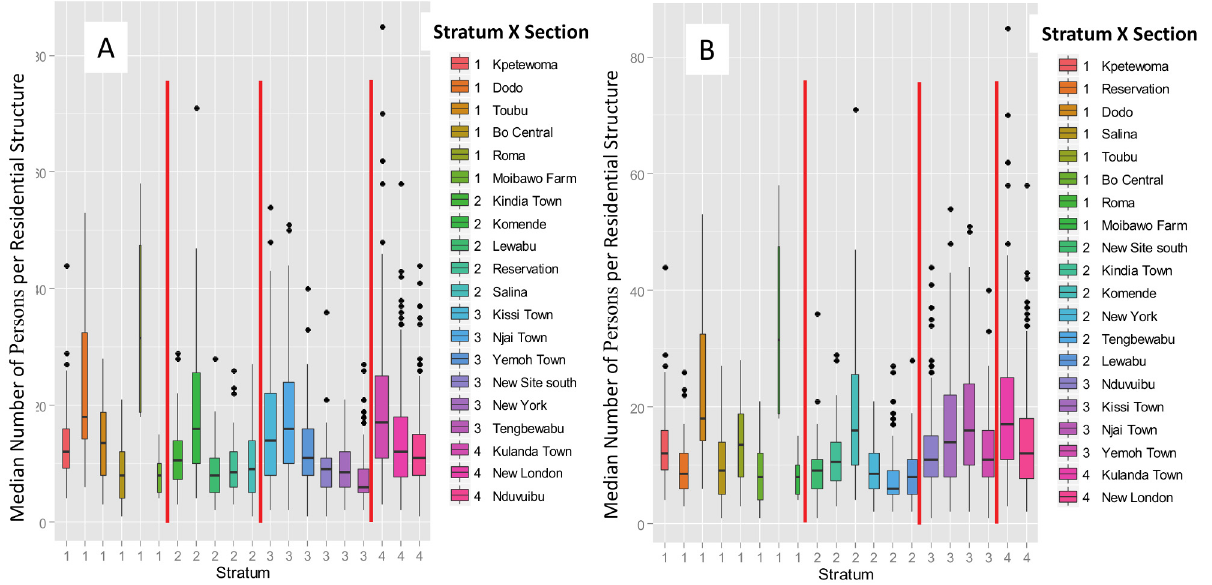
Fig 6. Quantile boxplots for single-stage cluster stratification by (A) “ residential structures per section ” and (B) “ total persons per section ” . (A) For the single-stage cluster sampling, the 20 sections were partitioned into 4 proportionally-allocated stratification levels. Within each stratum, the sections are arranged in descending order of total persons. The stratification variable is the total number of residential buildings per section (see Table 4). The quantile boxplots show the partitioning by stratum of the 1,979 records in the database, although only a subset of 4 sections will be drawn on a single simulation trial. The bar in each box is the median value of “ persons per residence, ” while outliers deviating by one or more quantiles from the median are denoted as discrete points. (B) Quantile boxplots showing stratification by total persons per section. This stratification approach requires that the population of each section be known, in contrast to stratification by residential structures per